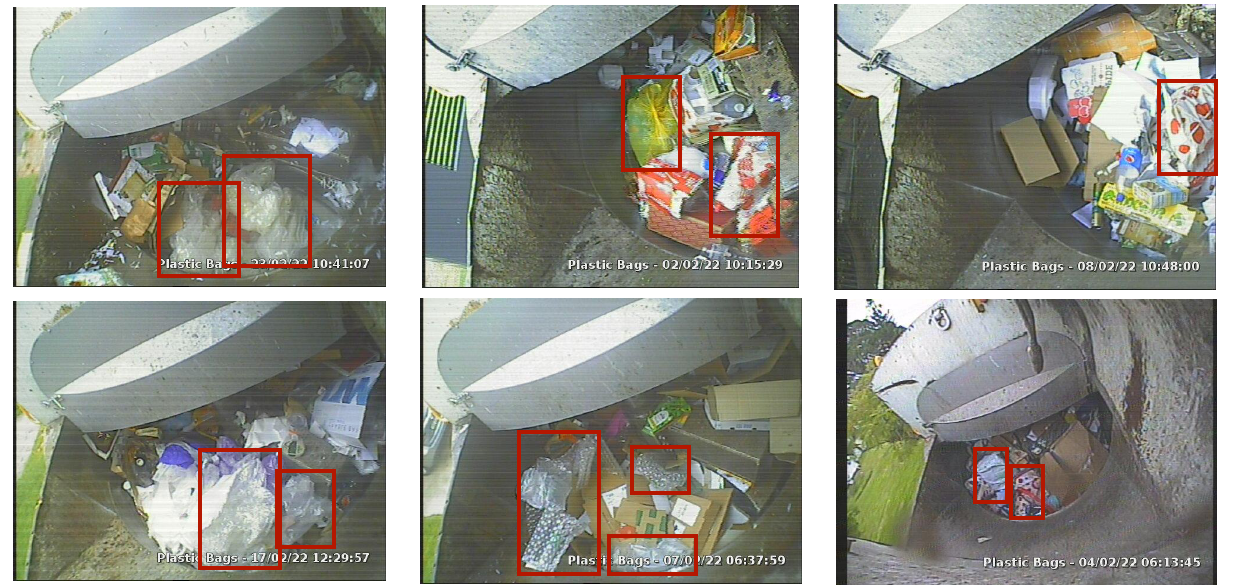
Figure 1. Annotated samples from the